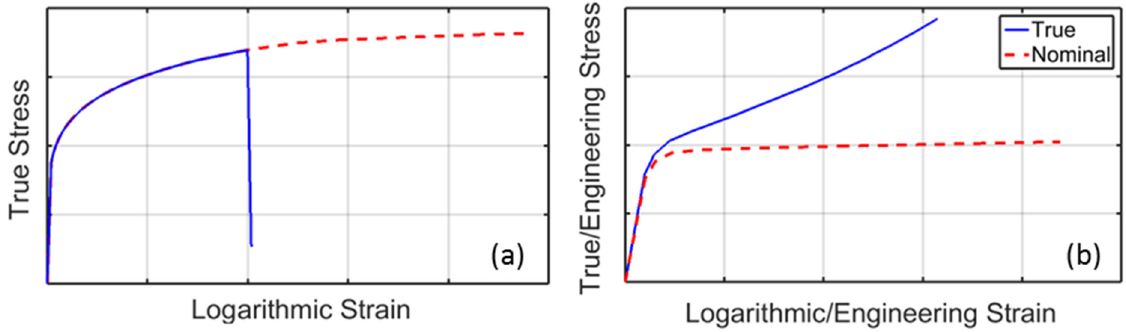
Figure 5. ( a ) Typical stress-strain response of free-standing aluminum foils (continuous line) and idealized constitutive law (dashed); ( b ) true stress-strain curve of the polyethylene layers (continuous line) and the resulting nominal response (dashed).